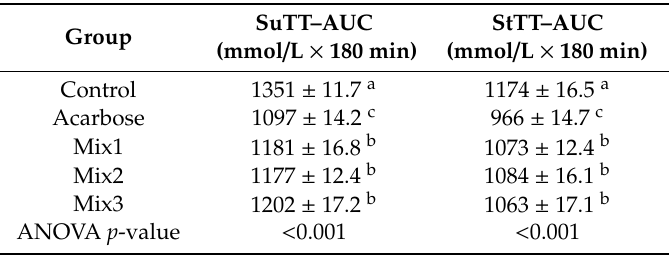
Table 2. The area under the blood glucose curve for the oral sucrose and starch tolerance tests in rats gavaged with acarbose or composed mixtures.